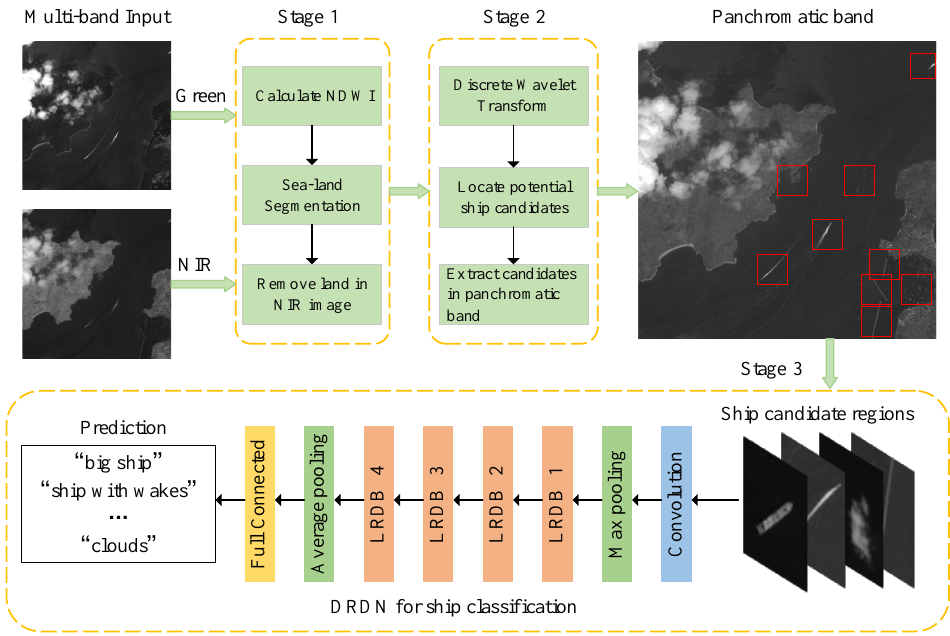
Figure 1. Workflow of the proposed method based on discrete wavelet transform and the deep residual dense network (DRDN). LRDB, local residual dense block.